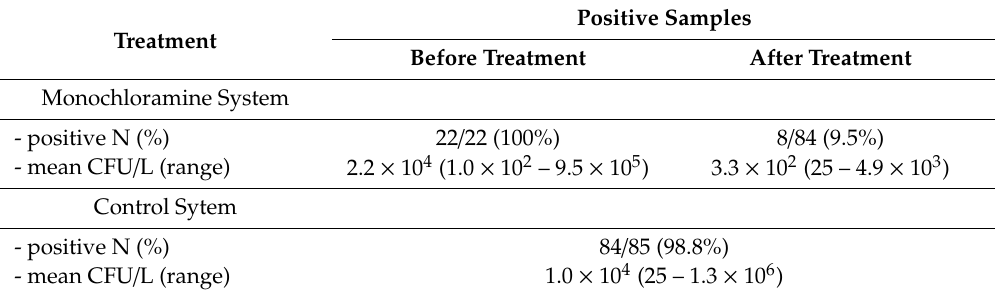
Table 3. Positive Legionella samples after monochloramine treatment. Adapted from